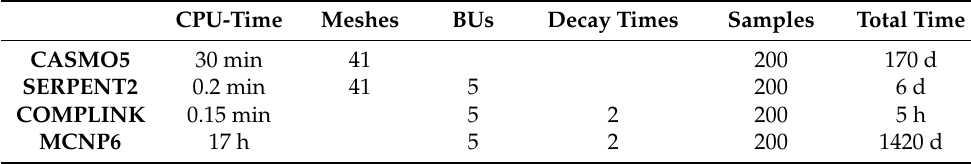
Table 5. Computational expense for each step of the UQ based on